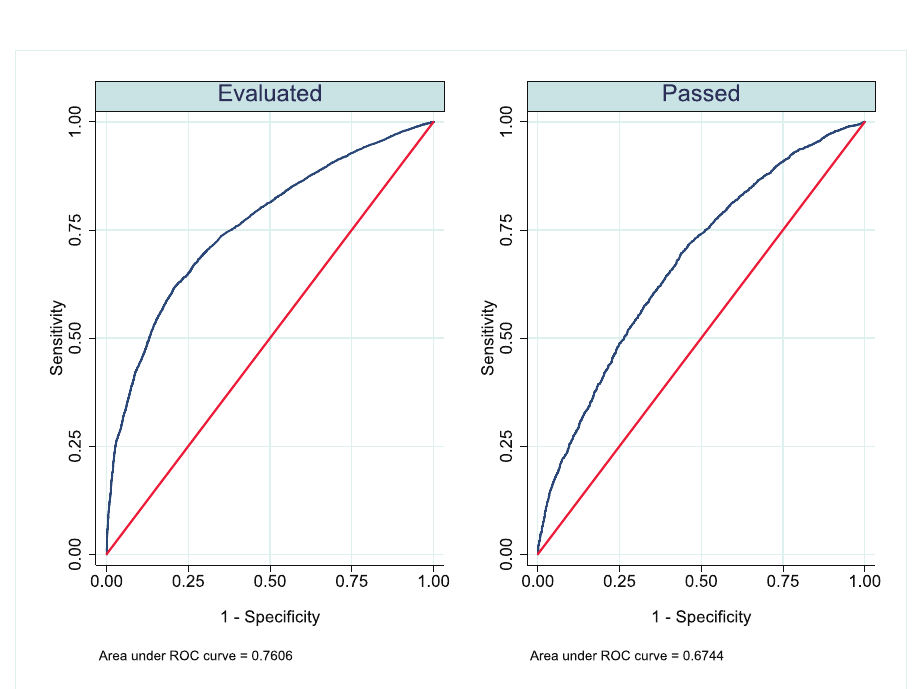
Fig 2. Receiver operating characteristic curves of the logit models.